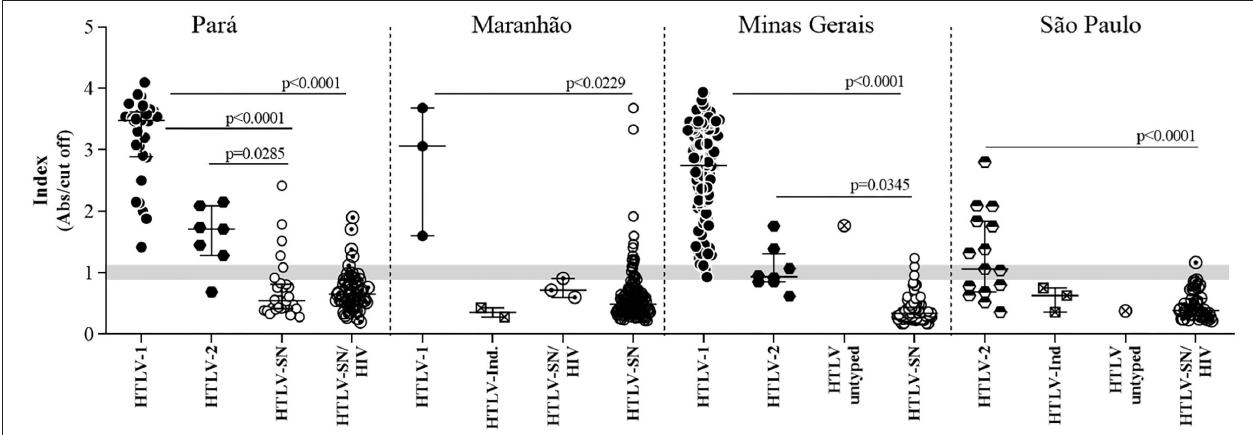
FIGURE 4 | Detection of the multi-epitope chimeric protein by human IgG from individuals infected or not by HTLV in samples from four different Brazilian states. Index values (Abs/cut off) of individuals infected with HTLV-1, HTLV-2, and HTLV and uninfected (SN) in the four states tested—Pará, Maranhão, Minas Gerais, and São Paulo. Ind.: Indeterminate status with CMIA or EIA positive and WB indeterminate pattern (Maranhão and São Paulo). Some HTLV-1 and HTLV-2 samples from Minas Gerais and São Paulo had coinfections, as described in Table 1 and include viral, parasitic and bacterial infections for Minas Gerais and HIV for all samples from São Paulo. HTLV untyped means that WB did not differentiate the infection as HTLV-1 or HTLV-2.